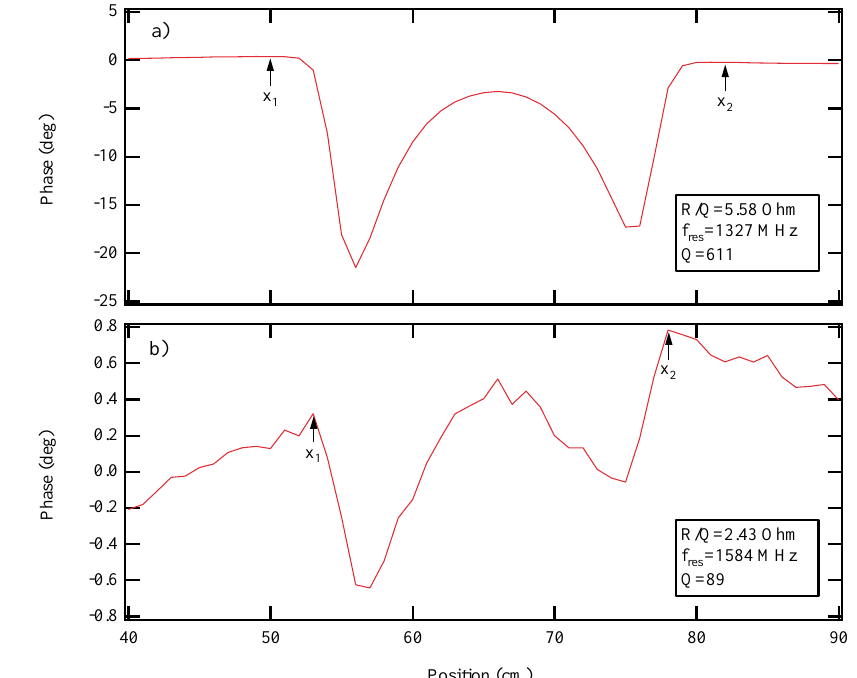
FIG. 5. (Color) Examples of bead-pull measurements. (a) The relatively strong 1327 MHz dipole mode shows an easily measurable phase shift. (b) 1595 MHz monopole mode provides a small phase shift with appreciable drift during the